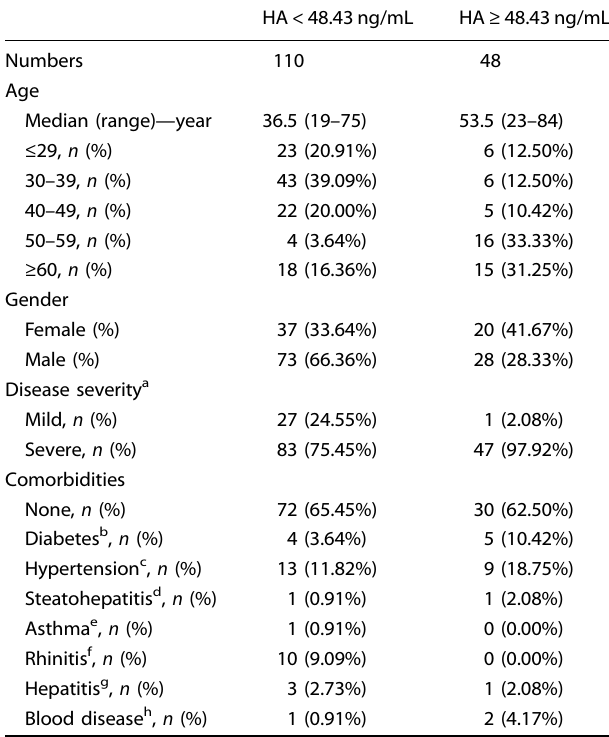
Table 1. The clinical features of the 158 patients in the observational